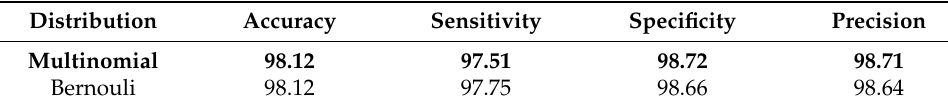
Table 5. The best distribution for the boosted regression tree.